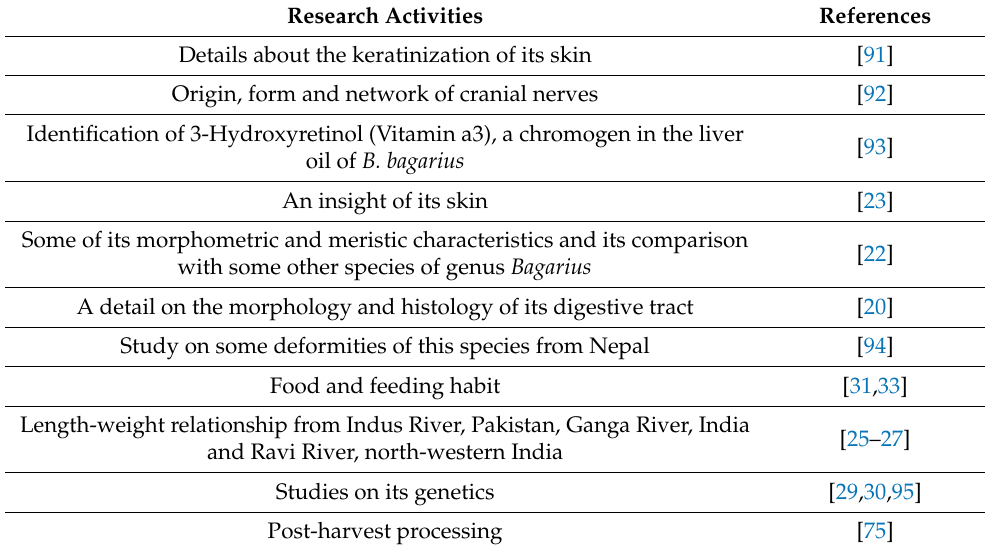
Table 8. Existing studies on B. bagarius around the